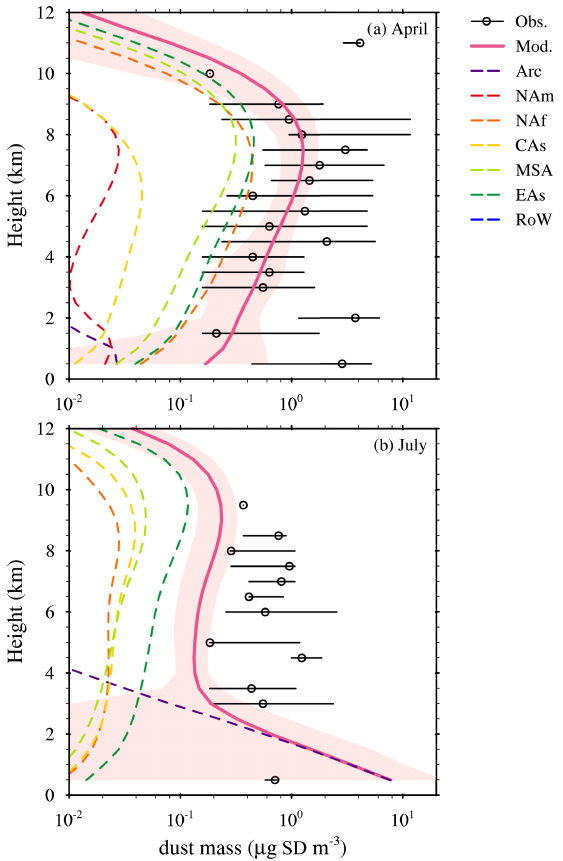
Figure 4. Comparison of vertical dust concentrations from ARC- TAS flight observations (Jacob et al., 2010) (black circle) and the CTRL simulation (pink solid line) in (a) April and (b) July. We show median values for observations at each level. The maximum and minimum of the measurements at each level are shown by black lines. Contributions from the seven tagged sources in CTRL are shown by colored dashed lines. The ARCTAS dust mass concen- trations are derived from measured calcium and sodium concentra- tions. The measurement data are processed using the same method as Breider et al. (2014). Briefly, we assume a calcium to dust mass ratio of 6.8% and further correct the calcium concentrations for sea salt by assuming a calcium to sodium ratio of 4%. Only measure- ments obtained north of 60 ◦ N are used for the analyses. The low- altitude observations near Fairbanks, Barrow, and Prudhoe Bay are removed. Also, data from below 1km on 1, 4, 5, and 9 July are removed to exclude the influence of wildfire. The ARCTAS flight campaign was conducted in 2008, while the modeled vertical pro- files are averaged for each April and July from 2007 to 2011, respec- tively. Following Groot Zwaaftink et al. (2016), the simulation pro- files are averaged for the regions north of 60 ◦ N and 170 to 35 ◦ W in April and 135 to 35 ◦ W in July. Also, the observations have a cutoff size of 4µm and are thus only compared with simulated dust con- centrations in the same size range. The pink shading in each panel represents the standard deviation with respect to time and space for the simulated total dust